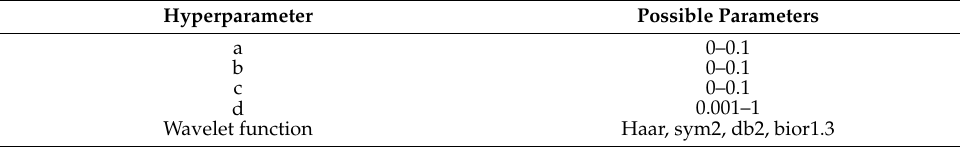
Table 2. List of hyperparameters used in the Bayesian optimization